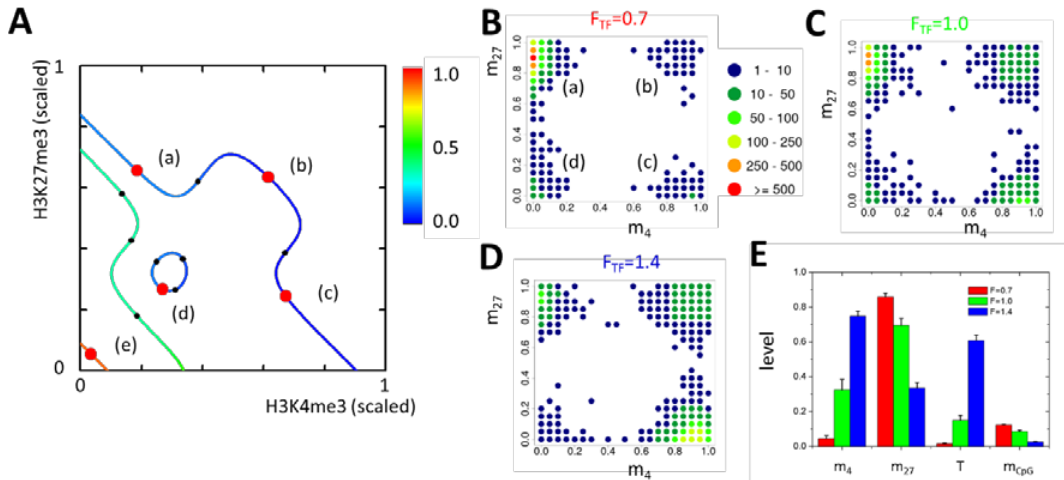
Figure 3. Epigenetic steady-state conditions. ( A ) Single gene states in the H3K4me3–H3K27me3 phase space. The epigenetic machinery defines a set of states that can potentially become occupied (lines, color code: DNA methylation level). The action of the transcriptional machinery is only consistent with a few of them (red and black dots). Beside eight unstable solutions (black dots), five stable states (red dots) are observed: one H3K27me3 (a), one bivalent (b), one H3K4me3 (c), and two unmodified states. Among the latter are one with low (d) and one with high (e) DNA methylation. The modification levels are non-linearly scaled: x k = 0.4 – 0.05 log 10 ((m k,max – m k ) / m k ), k = 4, 27. ( B–D ) Large perturbations enable reversible transitions between locally stable states. Thus, a steady-state distribution is observed (total cell count: 5000). With increasing transcriptional activation F TF of the model gene, H3K4me3 states become more frequent. The high DNA methylation state (e) is not reached, that is, unmodified states are all associated with low DNA methylation. ( E ) H3K4me3 (m 4 ), H3K27me3 (m 27 ), DNA methylation (m CpG ), and transcriptional (T) level averaged over a time period of 50 τ (average cell cycle time: τ = 1 day, [29]). Averaging was started after an equilibration time of 50 τ.